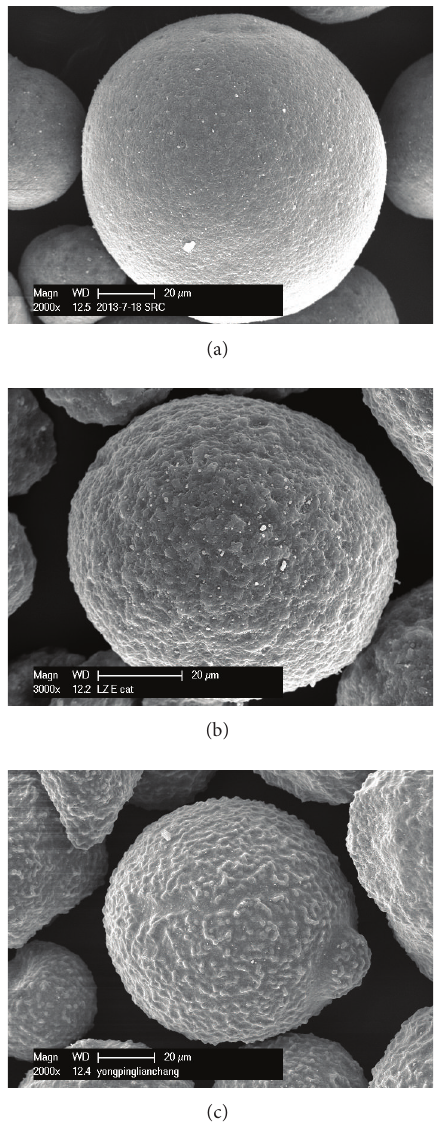
Figure 1: SEM images of E-cat iron poisoning ((a) low iron; (b) moderate iron; (c) high